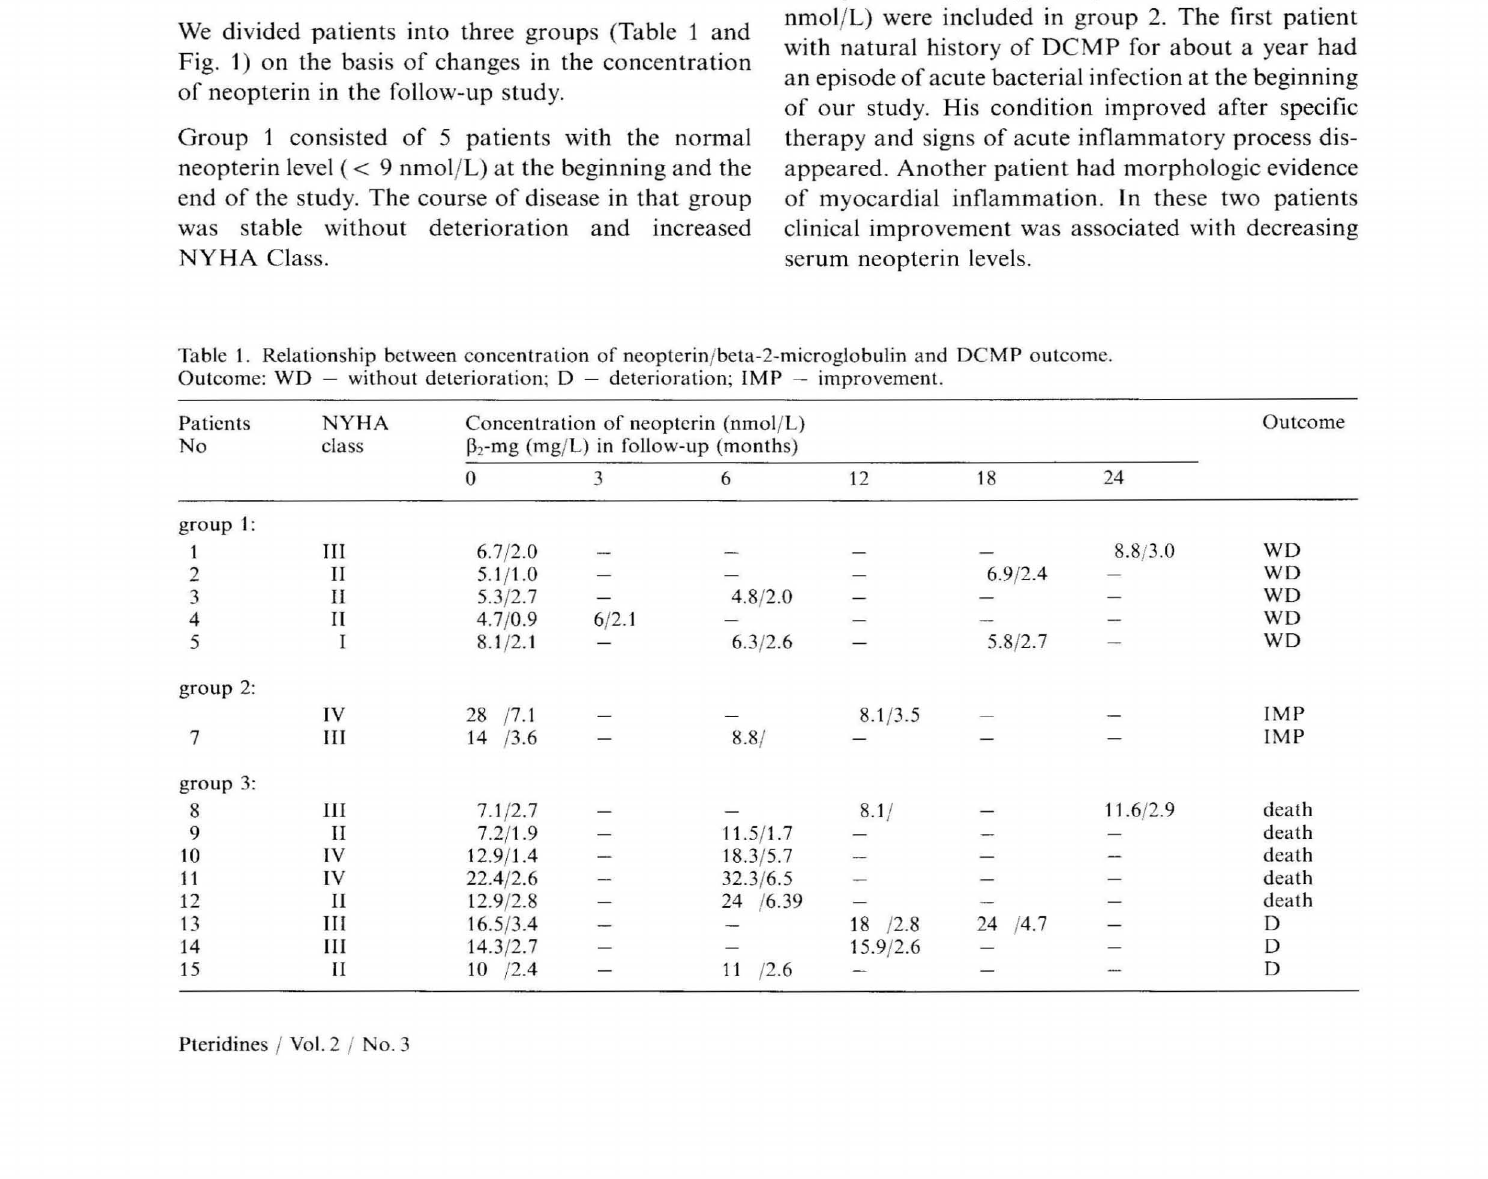
Figure 1. Changes in neopterin levels of DCMP patients during the follow-up study. Neopterin levels in patients: o = group 1 1\ = group 2 o = group 3 • = patients death